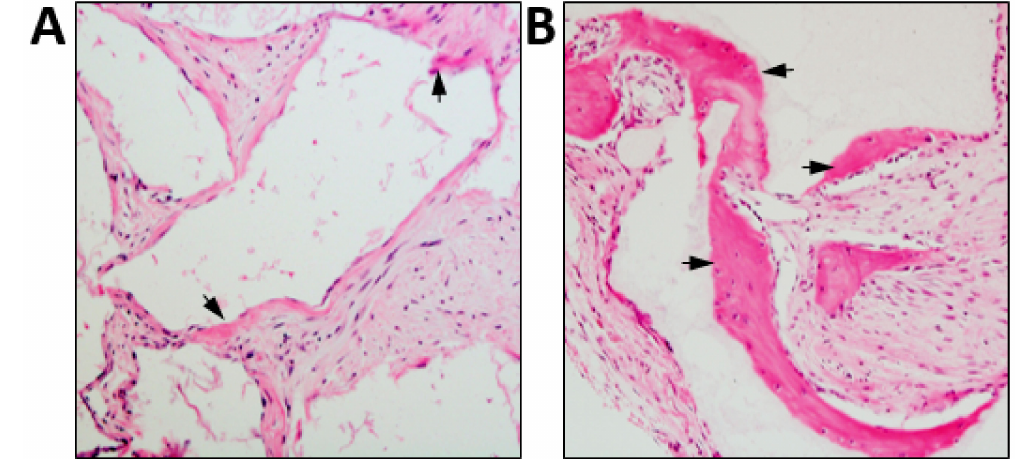
Figure 2. Di ff erential osteoconductive properties of bio-materials. Culture expanded human BMSC were seeded onto ( A ) JAX 100% β -TCP (Smith & Nephew) or ( B ) Master Graft 15% HA / 80% β -TCP granules (Medtronic Sofamor Danek), then transplanted subcutaneously into immunocompromised NOD-SCID mice for eight weeks. Representative cross sections of each transplant are shown stained with H&E depicting new bone formation (arrows). Magnification